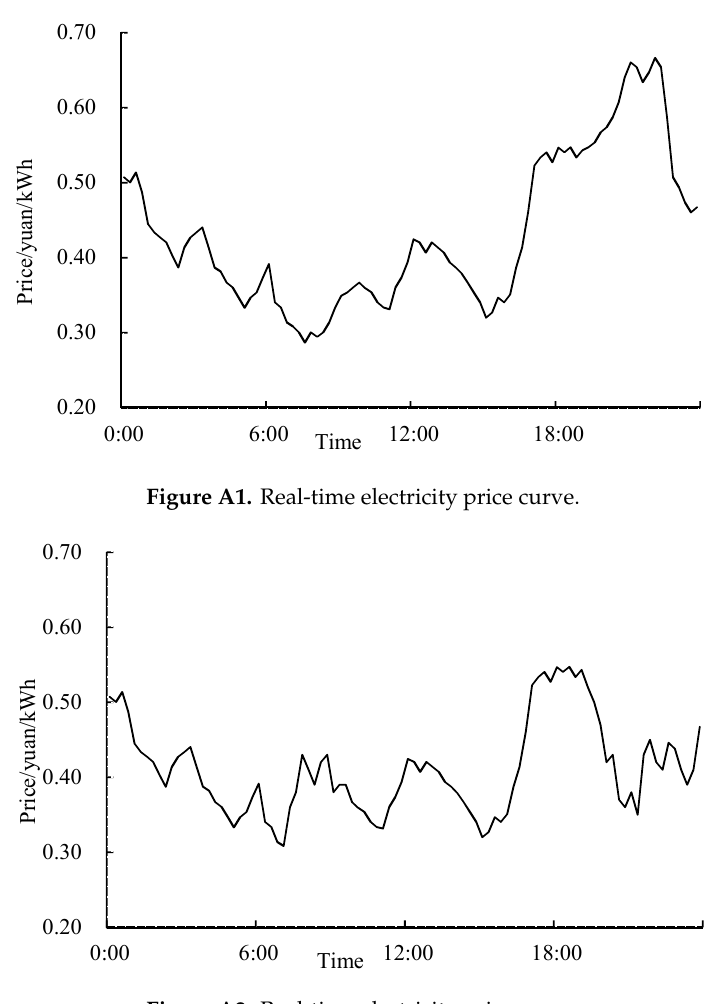
Figure A2. Real-time electricity price curve.